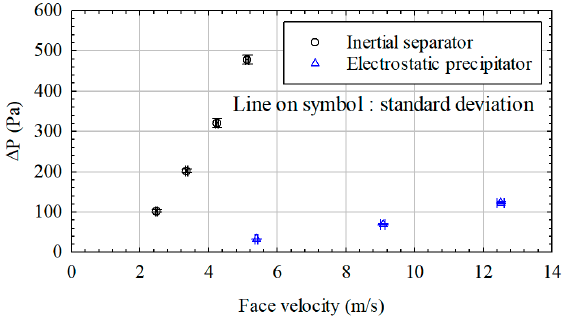
Figure 4. Differential pressure versus flow velocity curves for the inertial separator and the ESP.